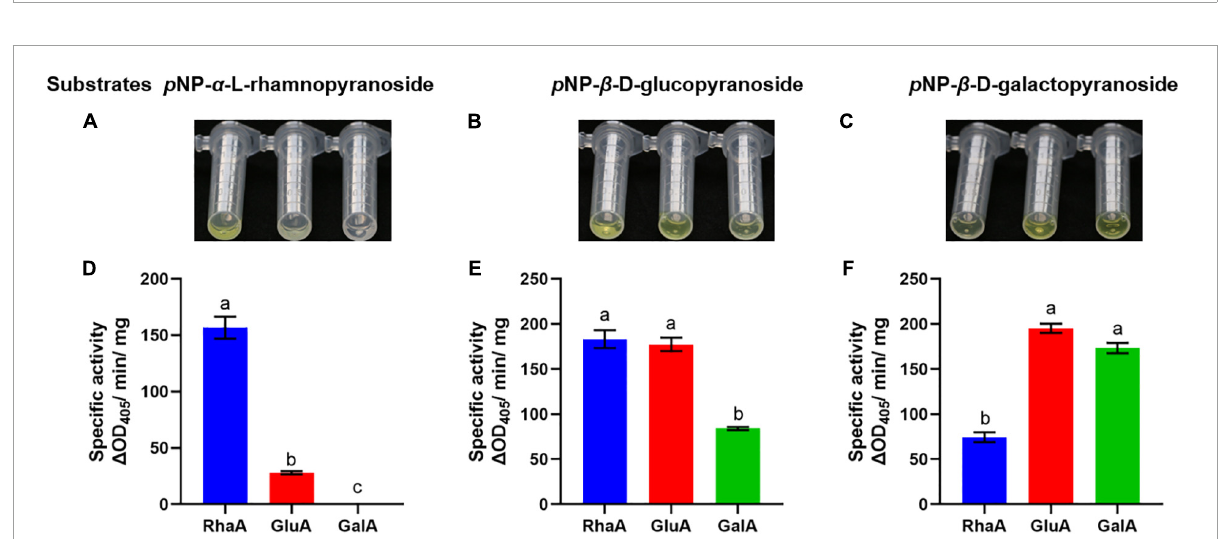
FIGURE2 Color reaction and specific activity of recombinant enzymes on the substrates p NP- α - L -rhamnopyranoside (A,D) , p NP- β - D -glucopyranoside (B,E) and p NP- β - D -galactopyranoside (C,F) . Bars (mean ± SD) labeled with different letters within each treatment are significantly different ( P < 0.05, Duncan’s multiple comparison, n =